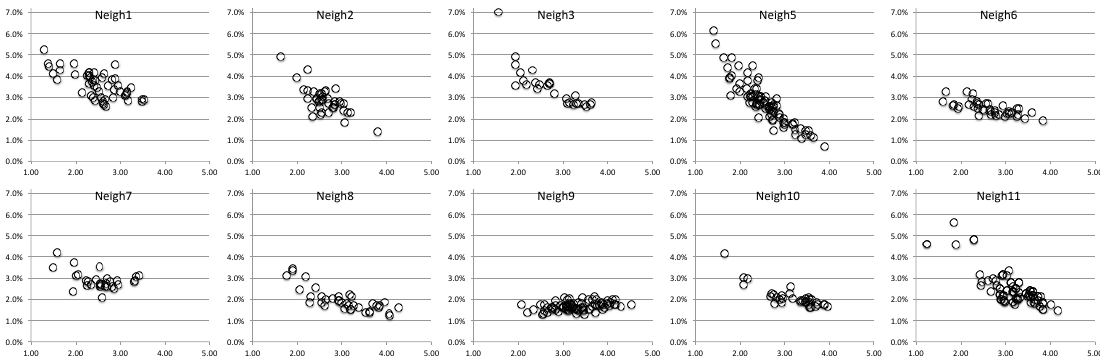
Figure 14. Cap rate and overall quality by